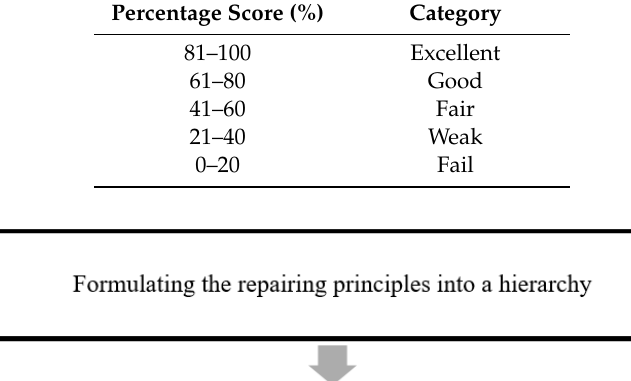
Table 5. Categories of percentage score.